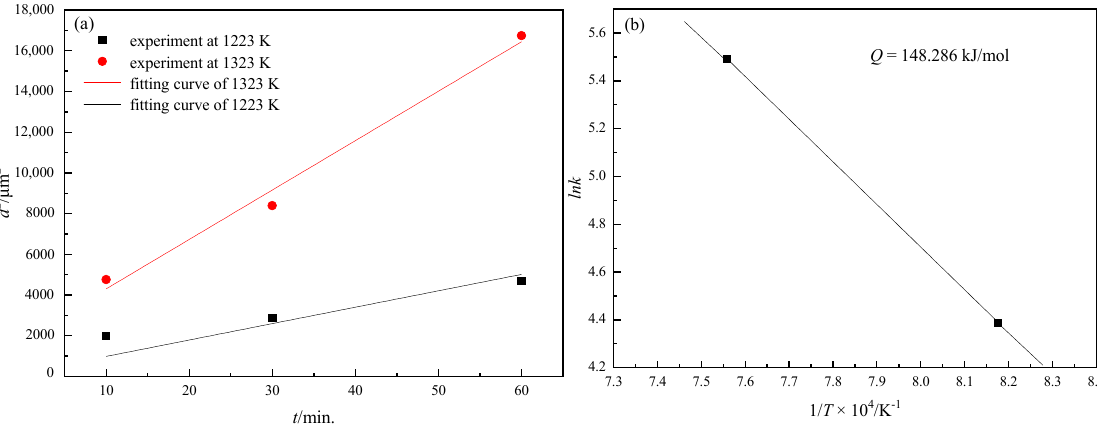
Figure 1. ( a ) Grain growth curve of Fe-3% Si steel at 1223 and 1323 K, ( b ) relationship between lnk and 1/T .